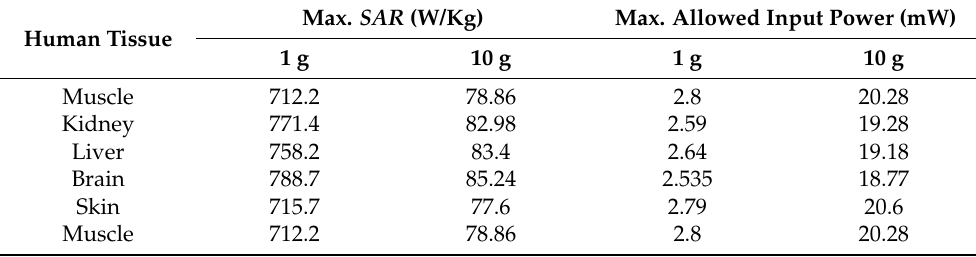
Table 3. Max SAR and maximum allowed power for 1 g/10 g human tissue. Human